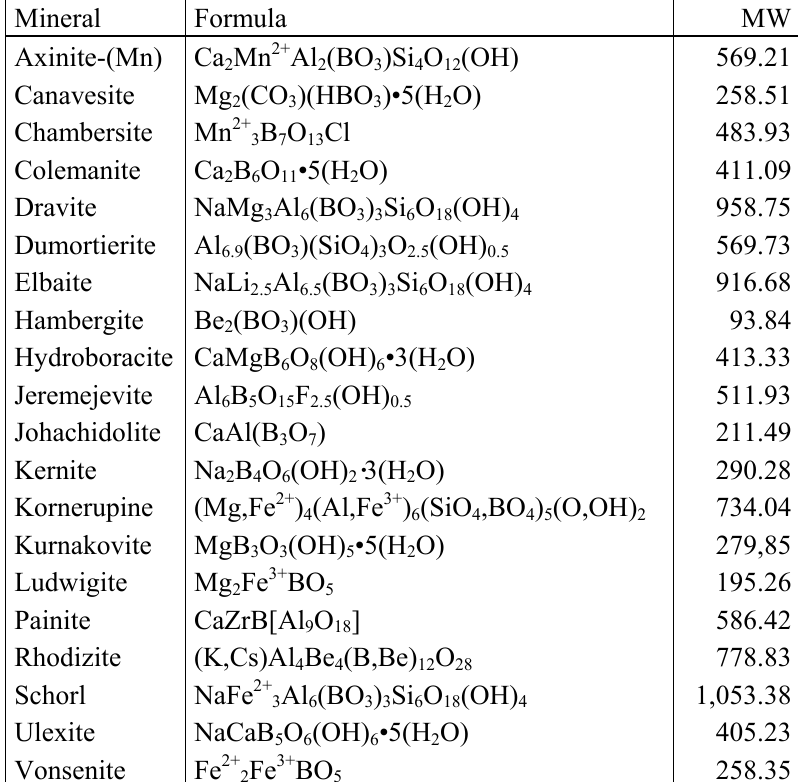
Table 1. The borate minerals